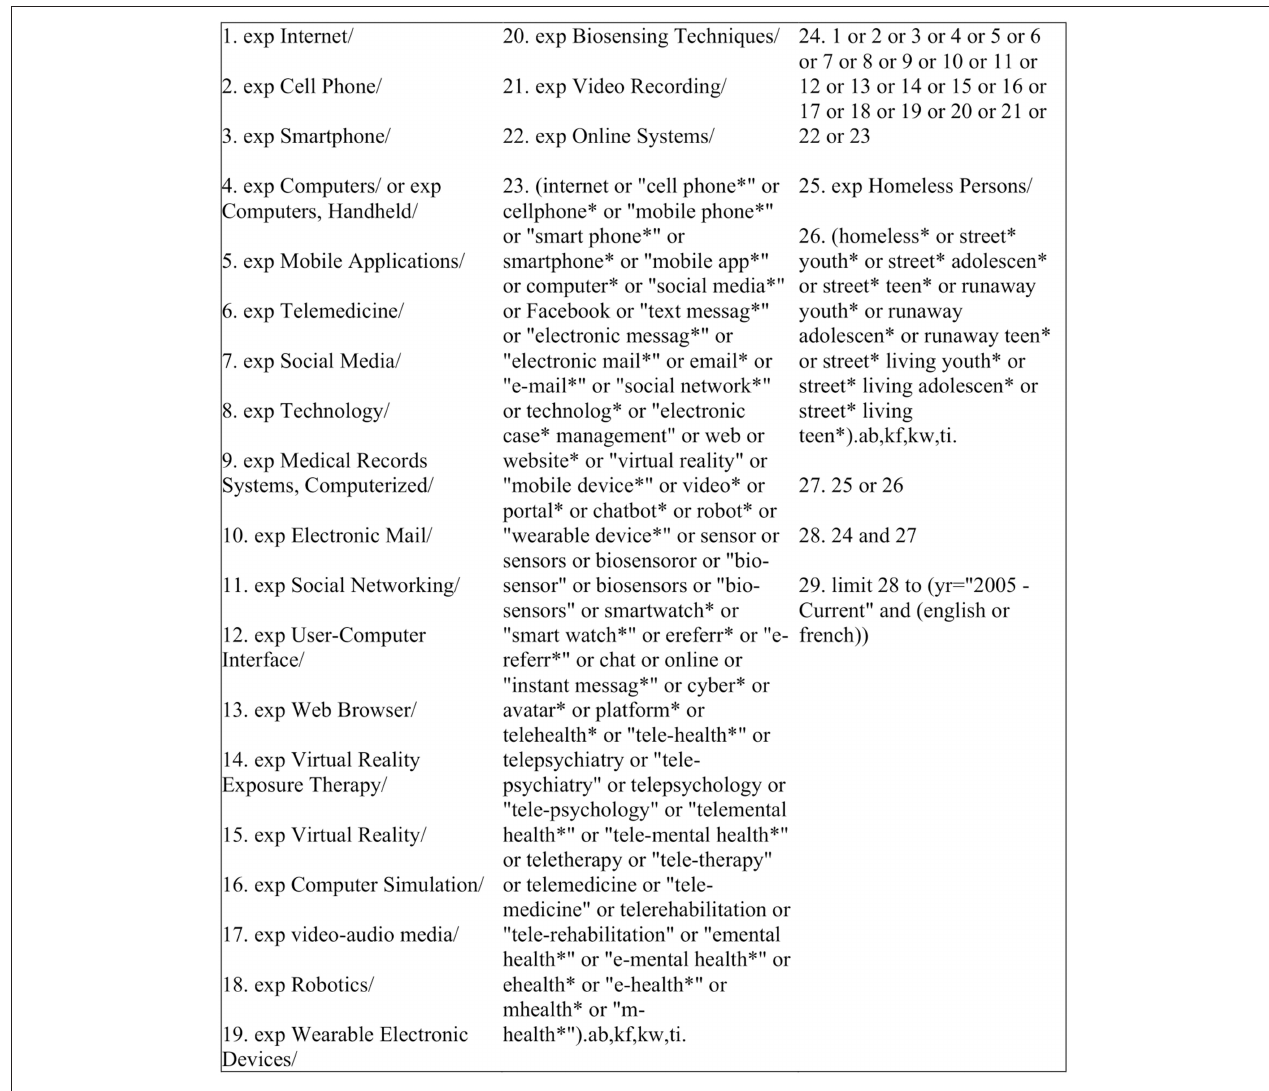
FIGURE 1 | 2019 search strategy launched in Medline. * refers to the inclusion of all forms of the word (e.g., plural